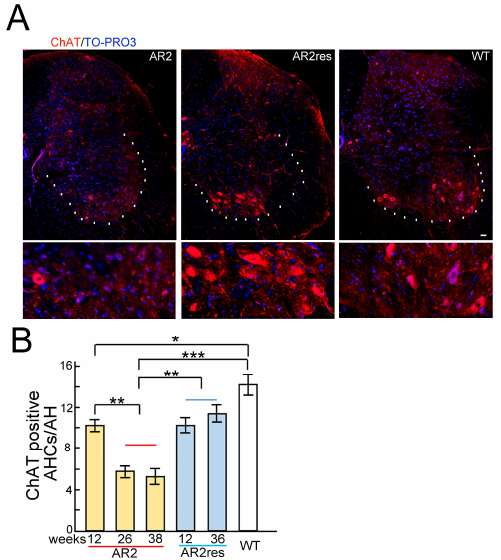
Figure 5. Choline acetyltransferase (ChAT) immunohistochemistry in the spinal cord of conditional adenosine deaminase acting on RNA 2 (ADAR2) knock-out mice (AR2) and AR2-rescued (AR2res) mice. ( A ) ChAT immunostaining (red) of the lumbar spinal cord. White dotted lines indicate the margin of the ventral gray matter. The bottom panels are the enlarged view of the upper panels. TO-PRO-3 (blue) was used as a cell marker. The scale bar indicates 20 µm; ( B ) As previously reported [19], the number of ChAT-positive anterior horn cells (AHCs) age-dependently decreases in AR2 mice compared to healthy controls. The age-dependent reduction in the number of ChAT-positive AHCs was rescued in AR2res mice. Means (columns) and standard errors of the means (SEMs; bars) are indicated. n = 5; * p < 0.05, ** p < 0.01, *** p < 0.001, Mann-Whitney U test against the value for wild type (WT) or AR2res groups.